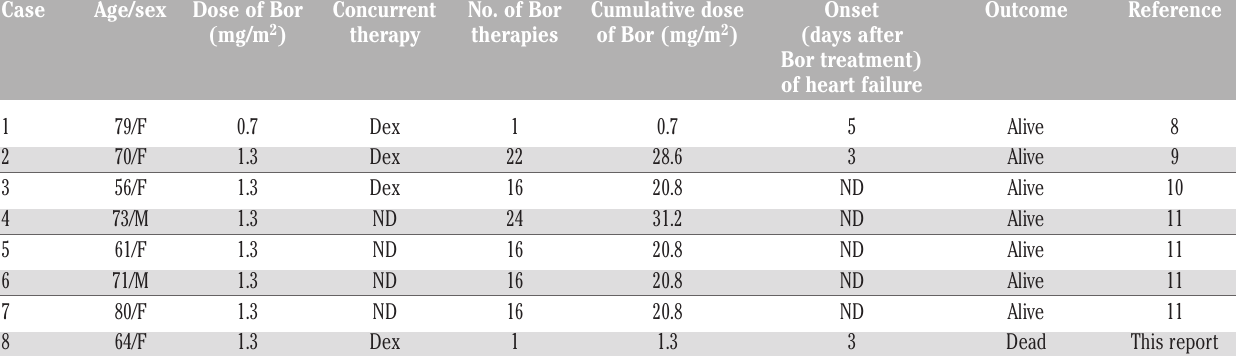
Table 1. Patients with heart failure after bortezomib treatment for multiple myeloma. Case Age/sex Dose of Bor Concurrent No. of Bor Cumulative dose Onset Outcome Reference (mg/m 2 )